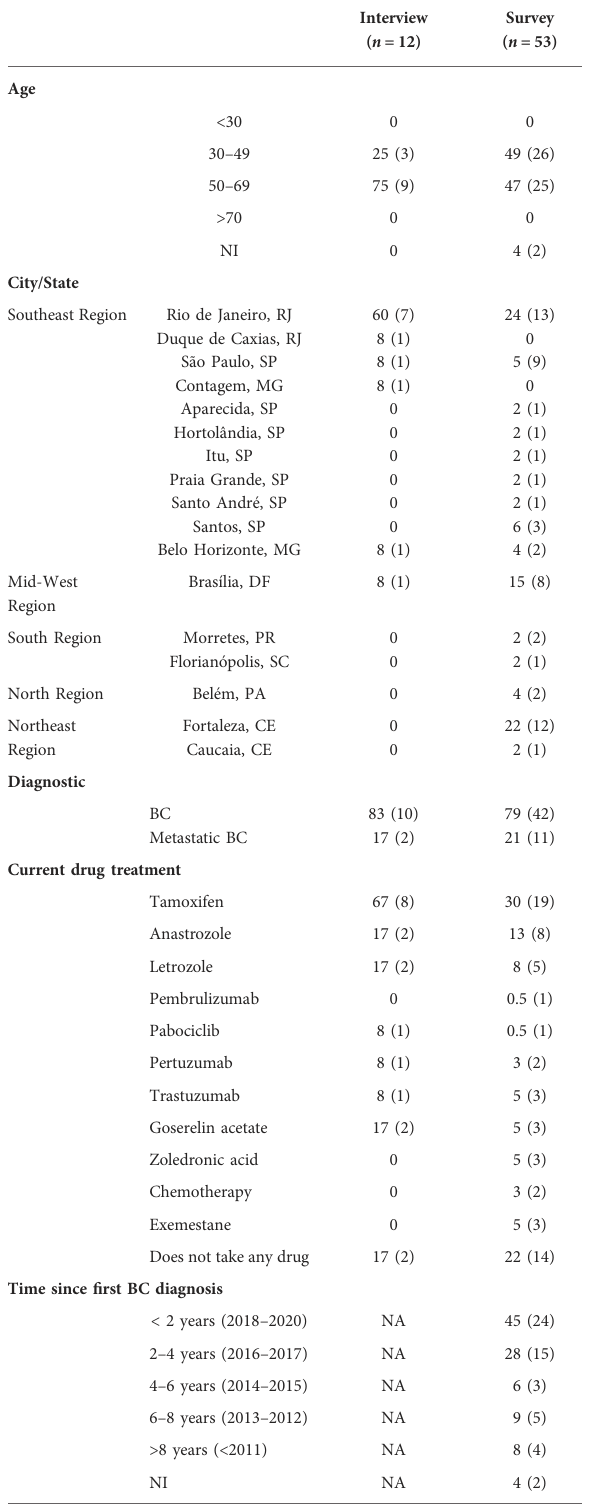
TABLE 1 Characteristics of the participants.